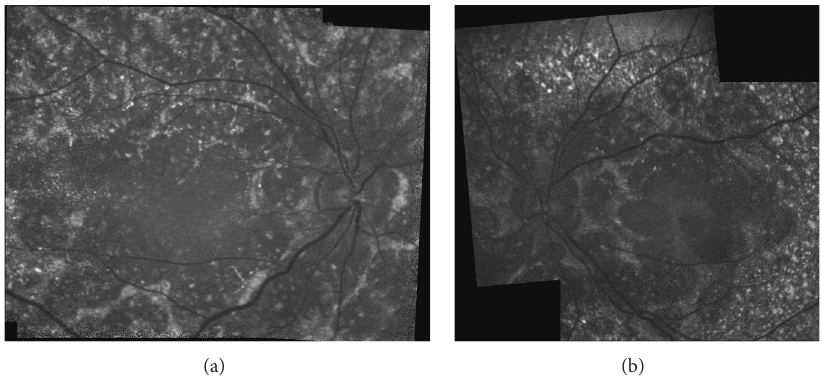
Figure 2: Composite fundus autofluorescent pictures demonstrating the central hypoautofluorescent areas and dot-like hyperautofluorescent spots surrounding the macula. (a) Right eye and (b) left eye.